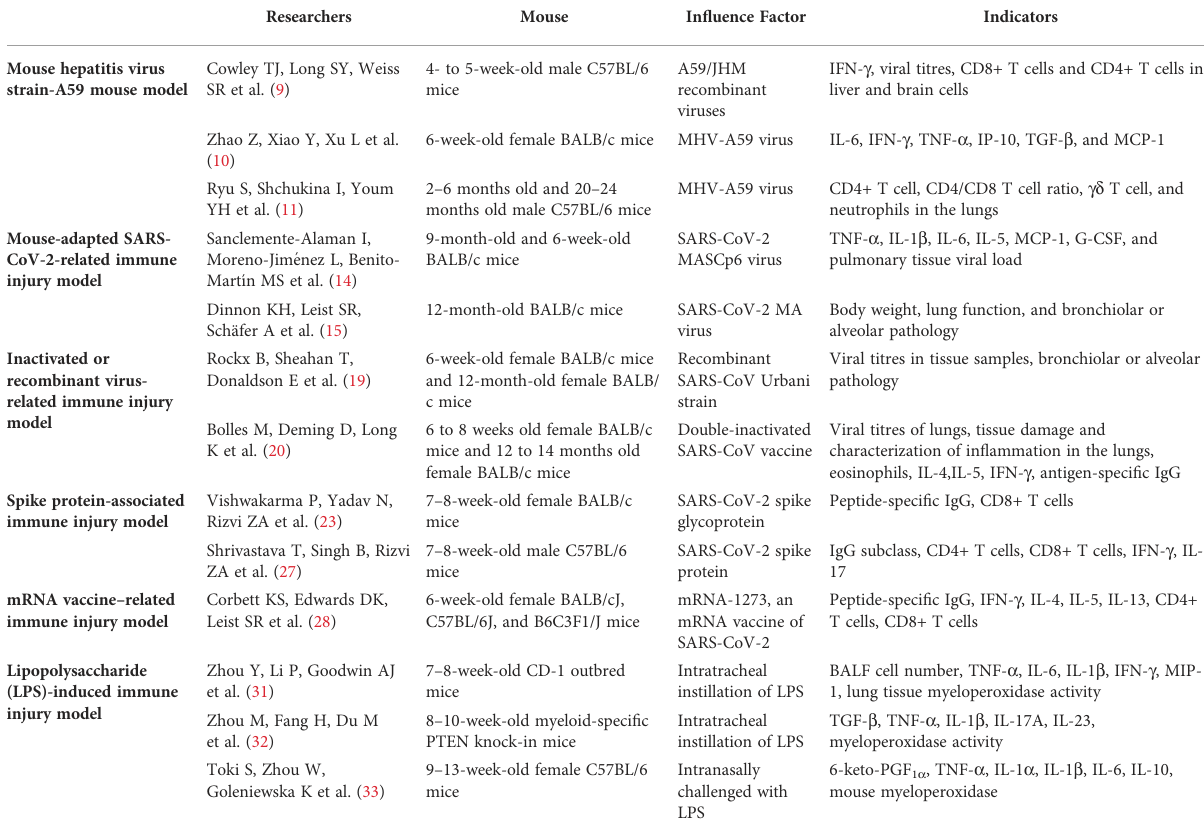
TABLE 1 Comparison of different mouse models of coronavirus-related immune injury. Researchers Mouse In fl uence Factor Indicators